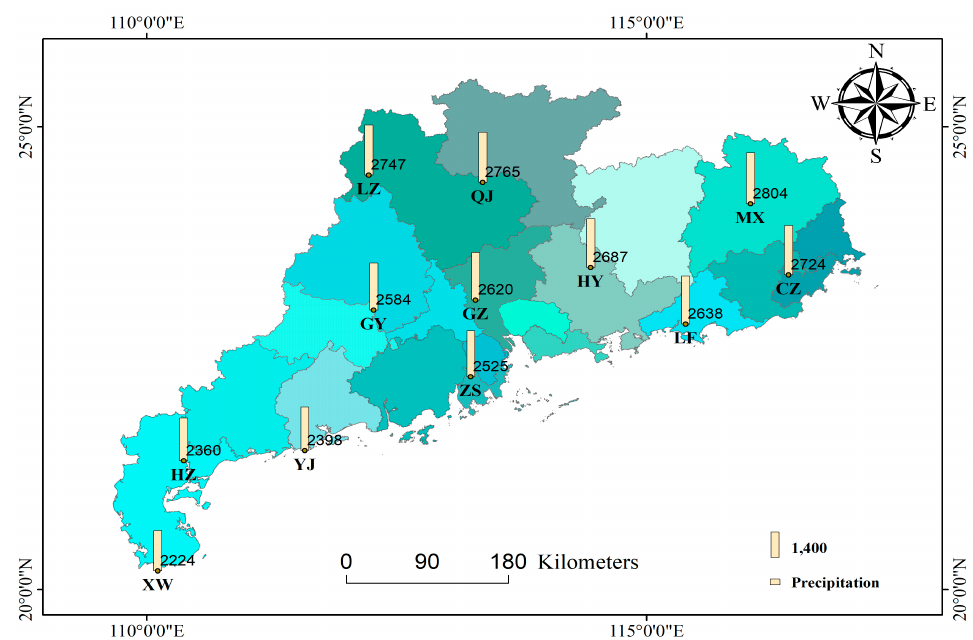
Figure 1. The study area, site locations and average annual precipitation (mm) from 1980–2010 are all indicated by histogram. The ‘words’ are the abbreviated names of sites, and the numbers indicate the average annual precipitation (mm).